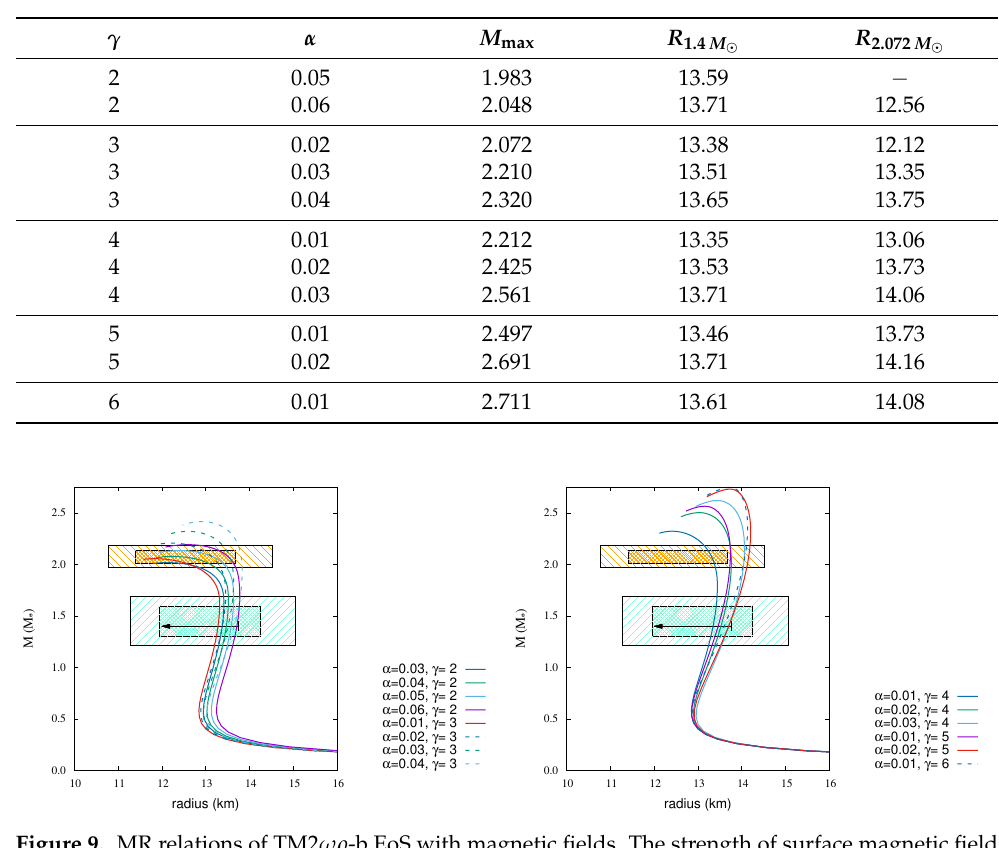
Table 9. Maximum mass ( M max ) in unit of M (cid:12) and radius (km) at M = 1.4 M (cid:12) ( R 1.4 M radius (km) at M = 2.072 M (cid:12) ( R 2.072 M B 0 = 2.5 × 10 18 G).